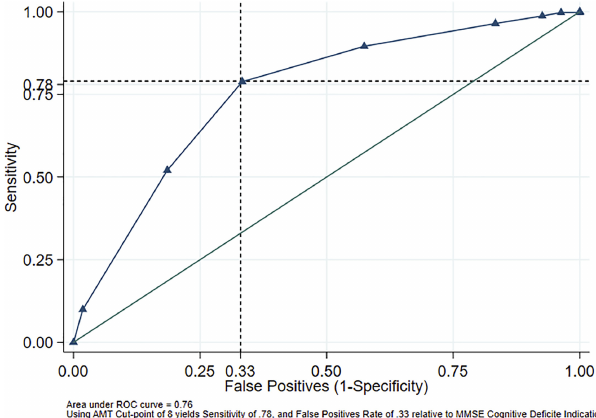
Figure 2. The receiver operating characteristic curves (ROC) of